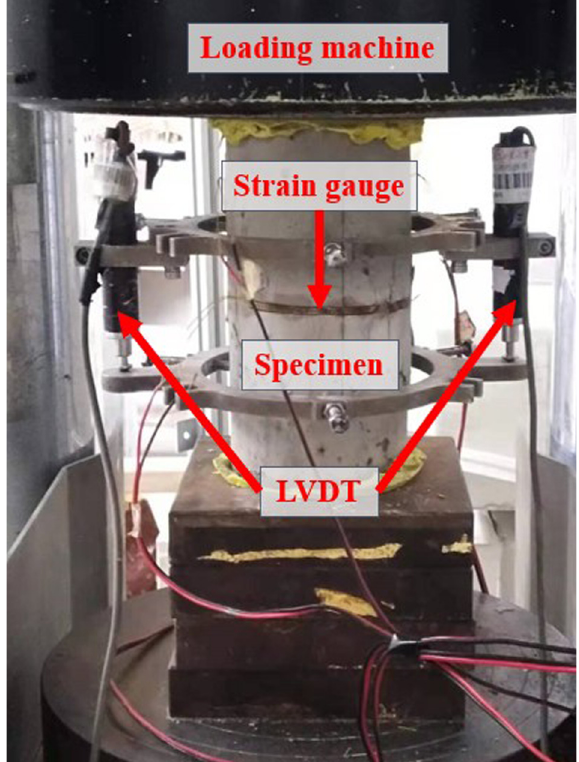
Figure 7: Cylinder compression test